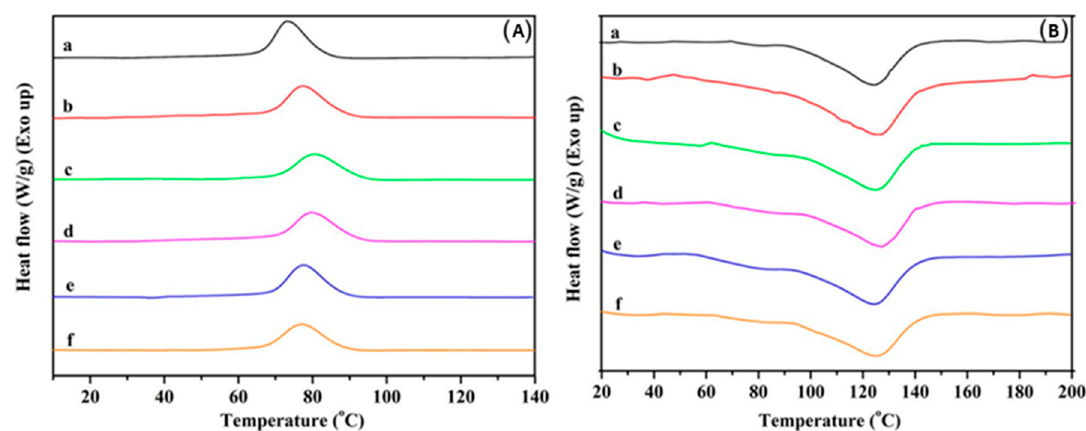
Figure 15. DSC cooling curves ( A ) and heating curves ( B ) for pristine PBAT and the different PBAT/chitin composites: ( a ) PBAT, ( b ) chitin-0.5, ( c ) chitin-1, ( d ) chitin-2, ( e ) chitin-4 and ( f ) chitin-8 [80].